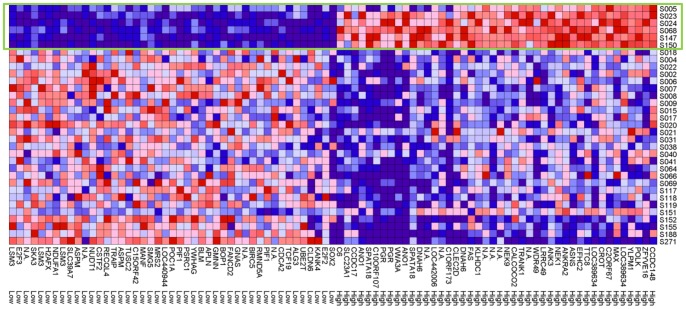
Analysis of gene expression.Seventy genes (89 probes) showing differences at FDR (BH) of <0.1 are displayed. ST1 is enclosed by the green rectangle. High and Low indicate expression levels of ST1 compared with ST2.